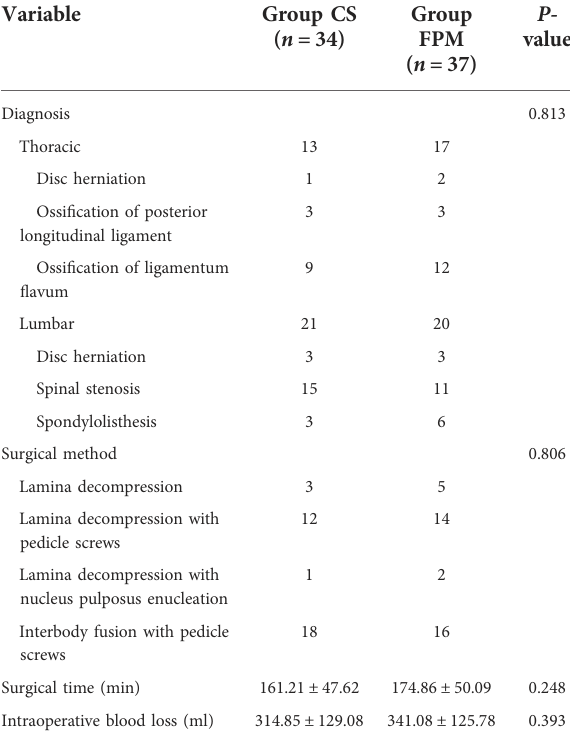
TABLE 1 Comparison of patient basic characteristics between group CS and group